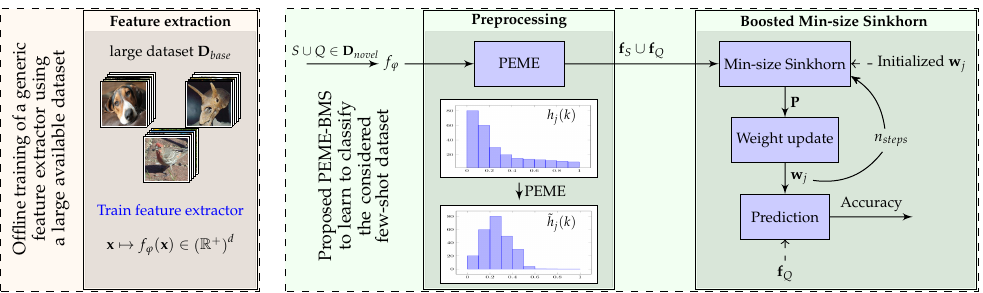
Figure 1. Illustration of the proposed method. A feature extractor is trained using a generic dataset. Obtained features on the few-shot dataset are then preprocessed using PEME (Power, Euclidian nor- malization, Mean subtraction, Euclidean normalization) to better align with a Gaussian distribution. They are then either directly fed to a classifier (inductive case), or processed through an optimal trans- port inspired algorithm using self-distillation and Boosted Min-Size Sinkhorn (transductive